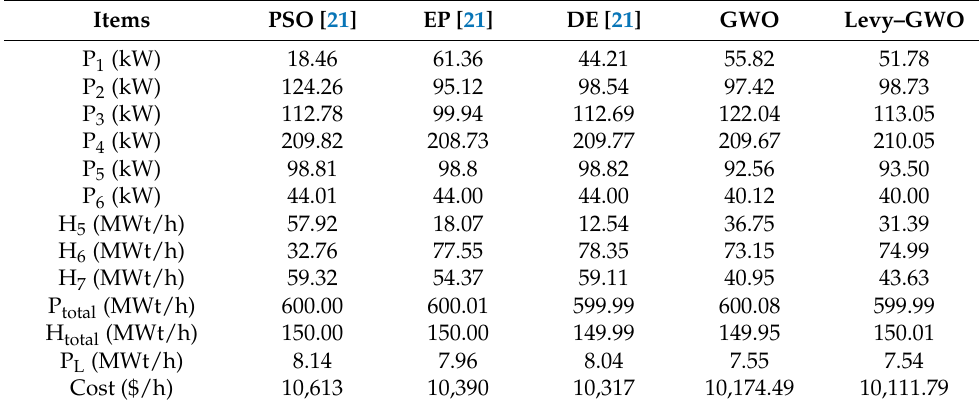
Table 4. Calculation results of different optimization algorithms for test system II.